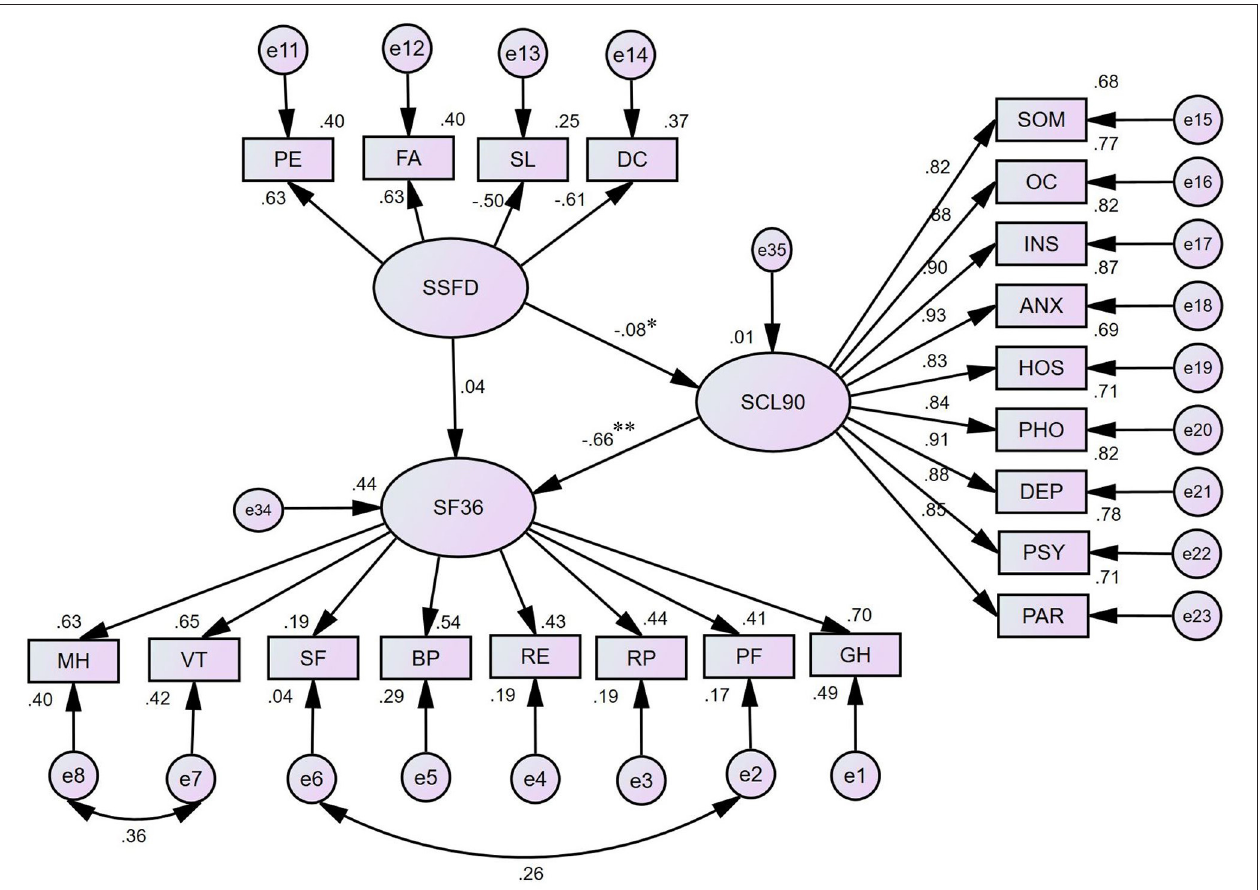
FIGURE 1 | The structure equation modeling for SF-36, SSFD and SCL-90-R. * P < 0.05; ** P < 0.01; SF 36, the 36-item short form health survey; SSFD, the self-rating scale of systemic family dynamics; SCL-90-R, the symptom checklist-90-revised; MH, mental health; VT, vitality; SF, social role functioning; BP, bodily pain; RE, role-emotional; RP, role-physical; PF, physical functioning; GH, general health perceptions; SOM, somatization; OC, obsessive-compulsive; INS, interpersonal sensitivity; ANX, anxiety; HOS, hostility; PHO, phobic anxiety; DEP, depression; PSY, psychoticism; PAR, paranoid ideation; PE, personalization; FA, family atmosphere; SL, system logic; DC, disease